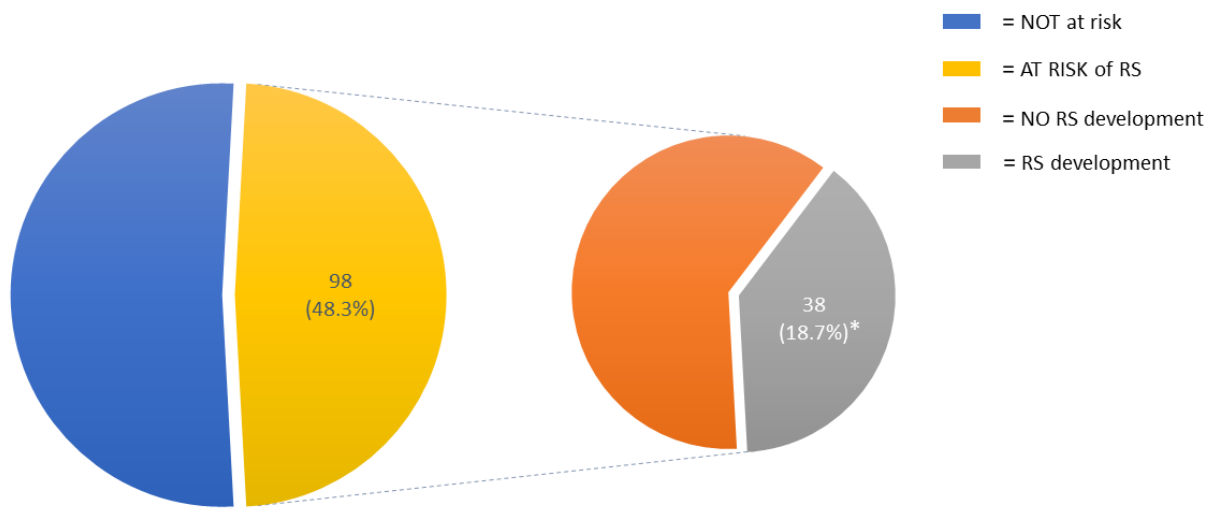
Figure 1. Incidence of RS risk and RS development in the entire cohort. Abbreviations: RS, refeeding syndrome. * = of the entire cohort.